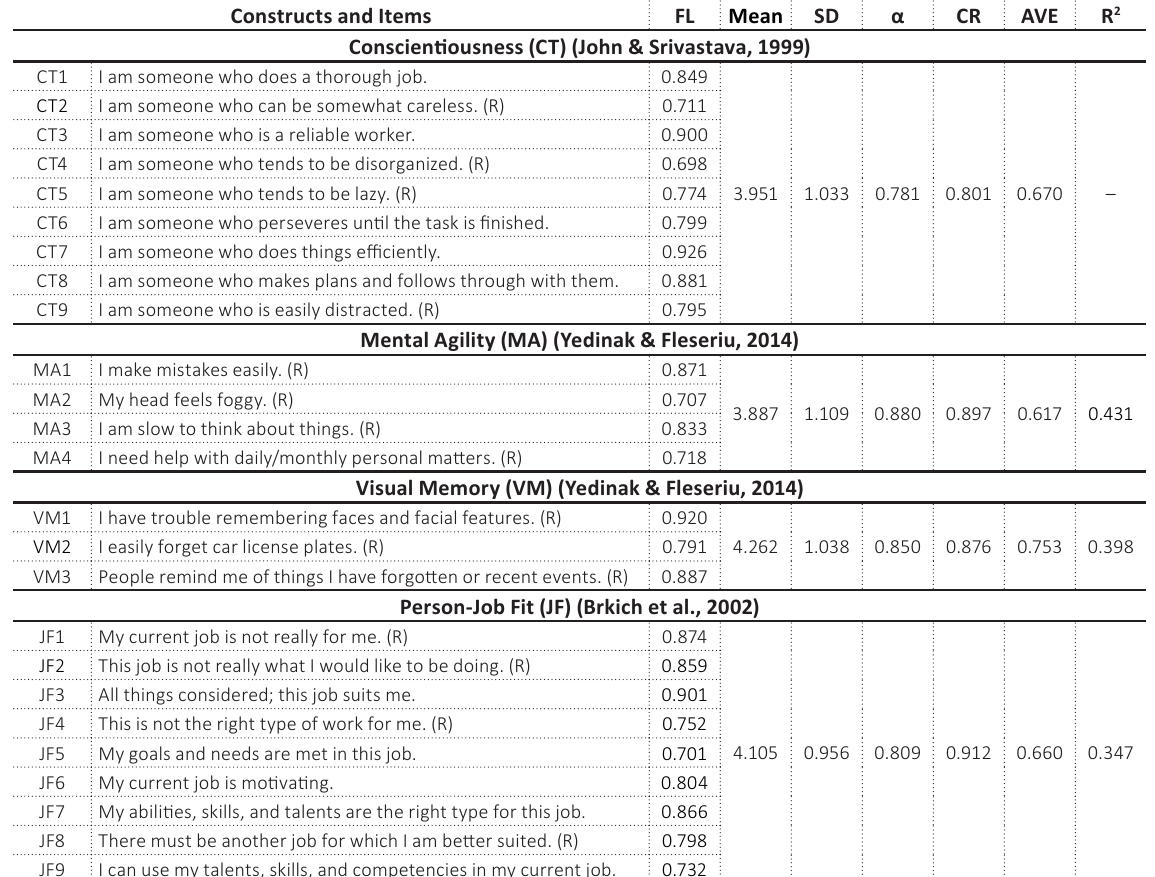
Table 2. Measurement model (loadings, reliability, and model determination) Constructs and